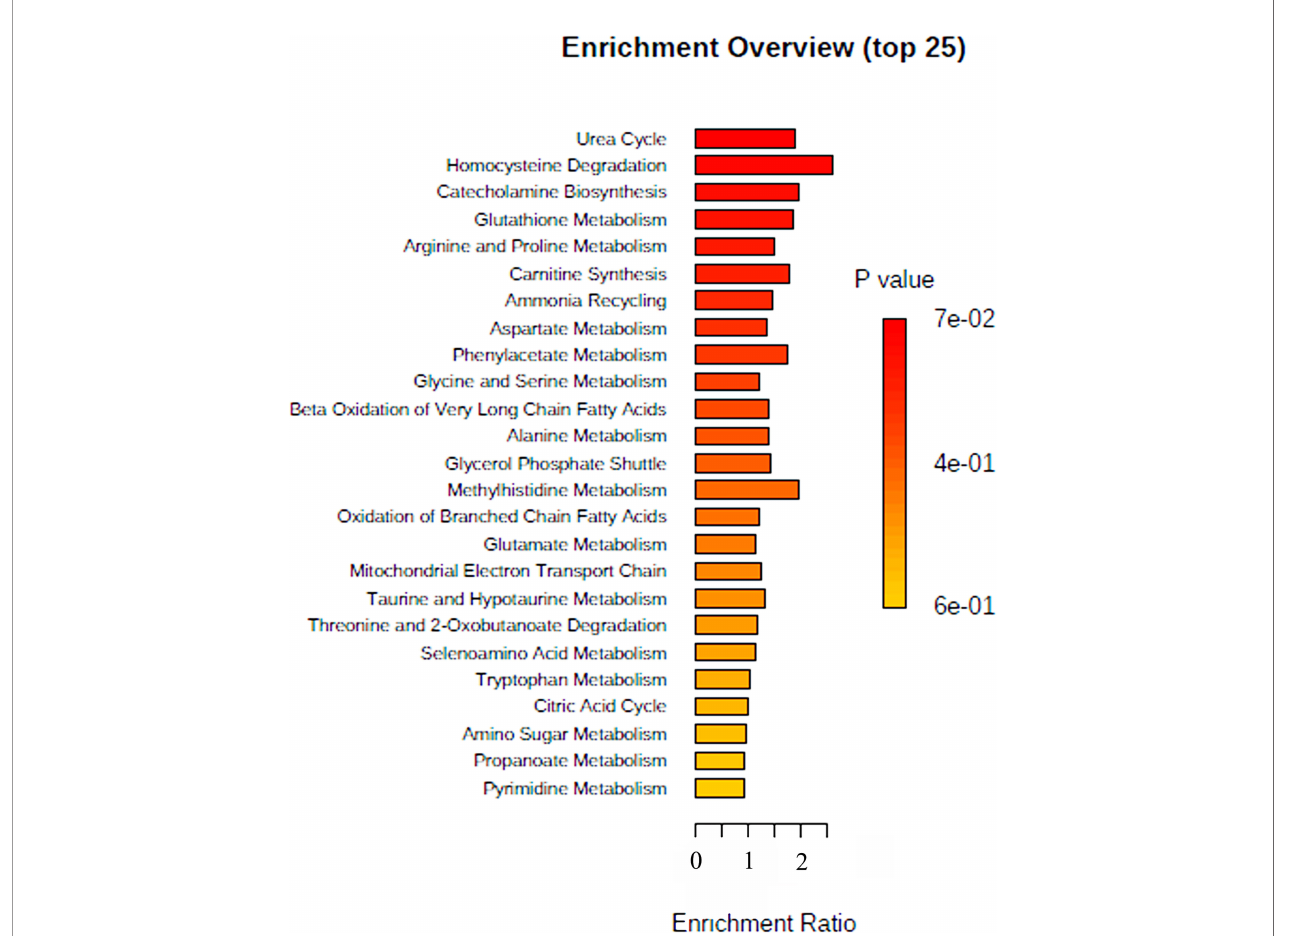
FIGURE 1 | Summary of Metabolomic Set Enrichment Analysis Plot. Metabolomic Set Enrichment Analysis (MSEA) showing the most altered functional metabolic pathways in COVID-19 patients. The graph was obtained using the online tool MSEA by plotting on the y-axis the -log of p values from pathway enrichment